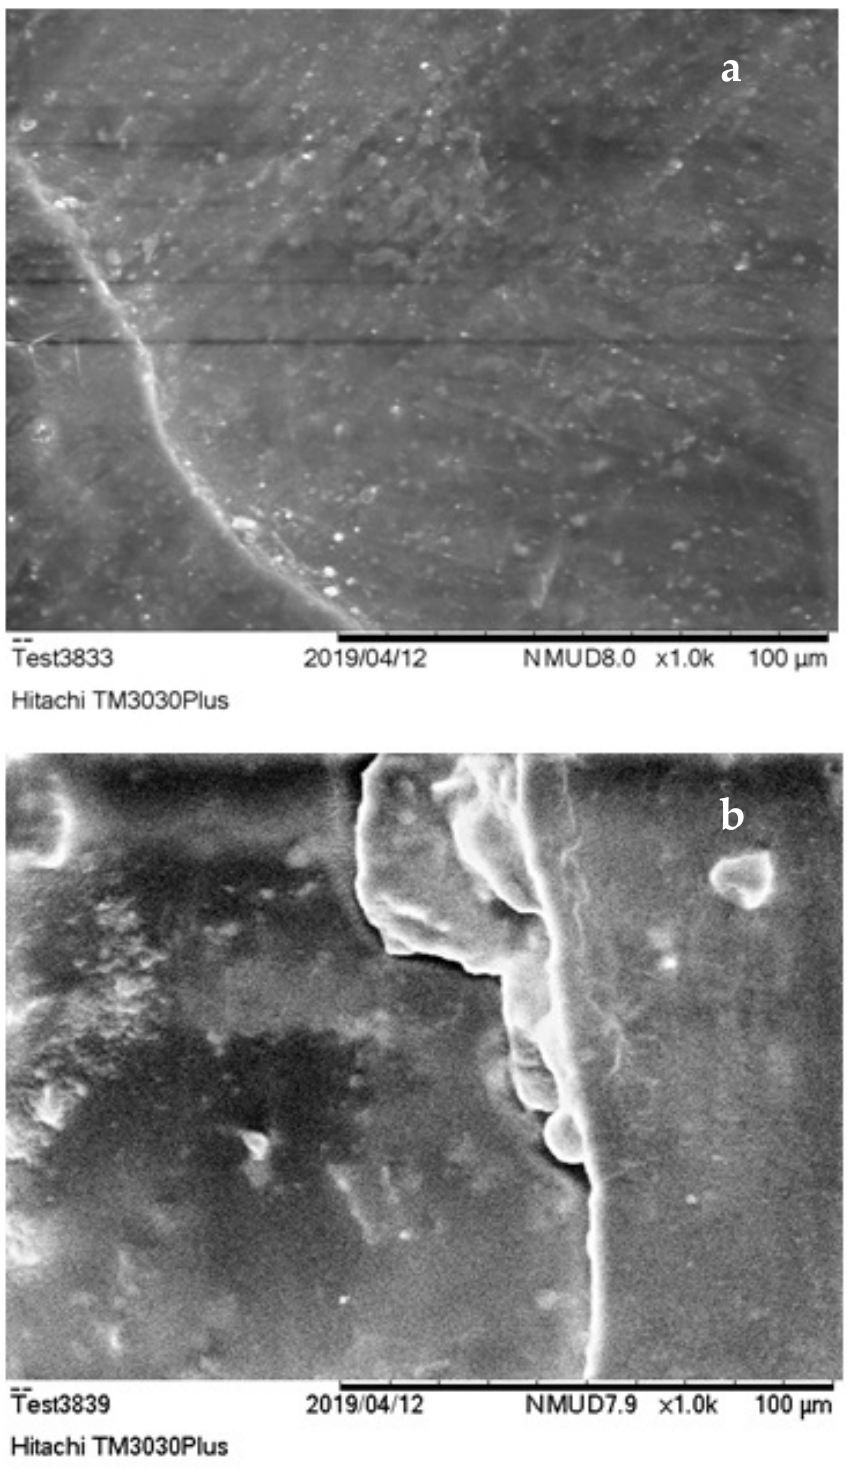
Figure 6. NCs SEM imaging; ( a ) 30% of 500 µ m C&D waste ( w / w ), magnified × 1000 and ( b ) 30% of 300 µ m C&D waste ( w / w ), magnified × 1000.